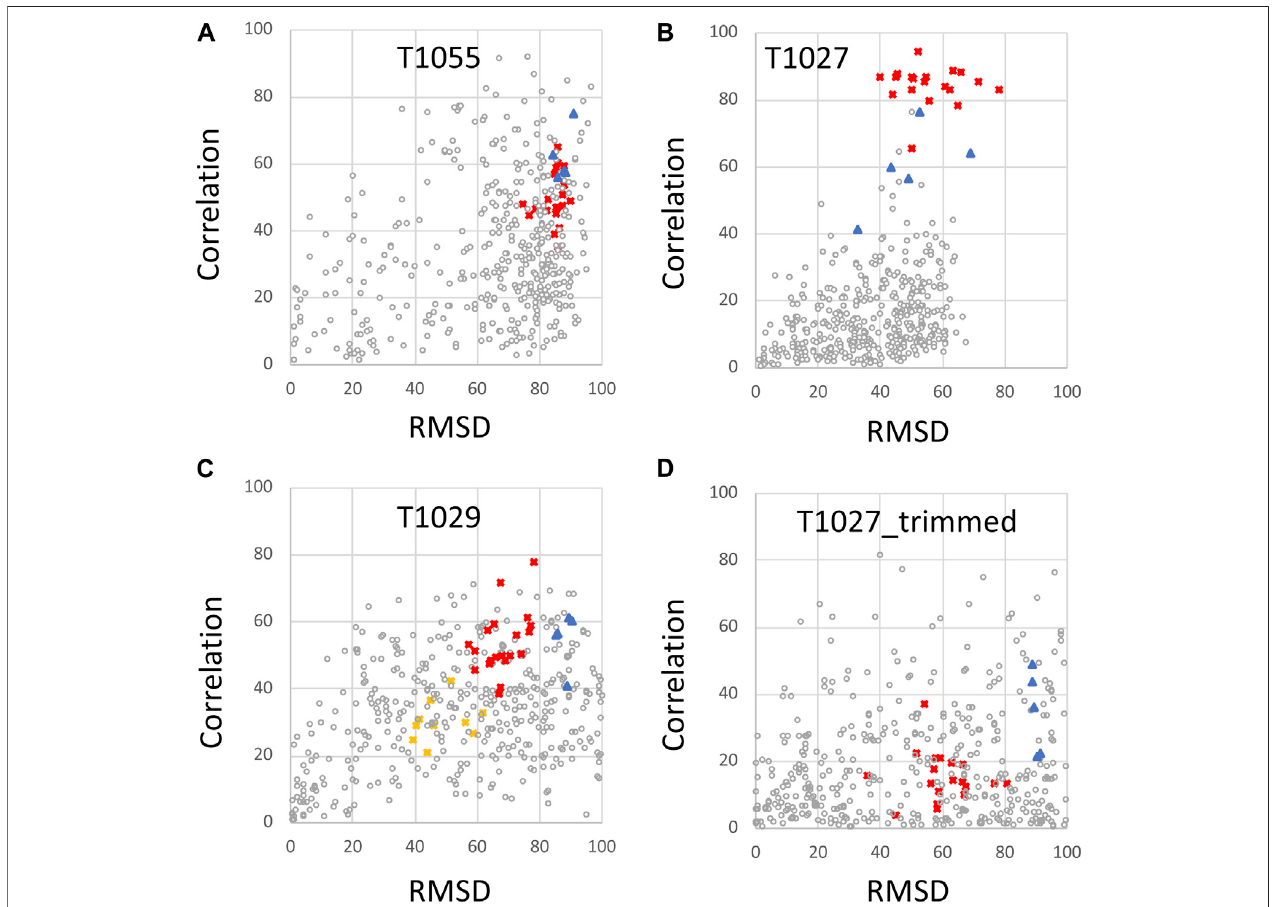
FIGURE 3 | ANSURR Correlation vs. RMSD scores for NMR and AlphaFold prediction models. (A) CASP14 target T1055, (B) T1027, (C) T1029 (data shown for both T1029_originaland T1029_revisedNMR structures), and (D) target T1027_trimmed (residues36 – 75and 96 – 145) inwhichcoordinates aretrimmed toremove the structurallynot-wellde fi ned(i.e.,unreliable)polypeptidesegments.Asin Figure2 ,ineachpanel,theopencirclesareCASP14predictionmodels(excludingAFmodels), red squares are the fi nal NMR structure models, including T1029_revised, blue triangles are AF prediction models, and yellow squares [in panel (C) ] are for the original NMR structure of target T1029, i.e.,